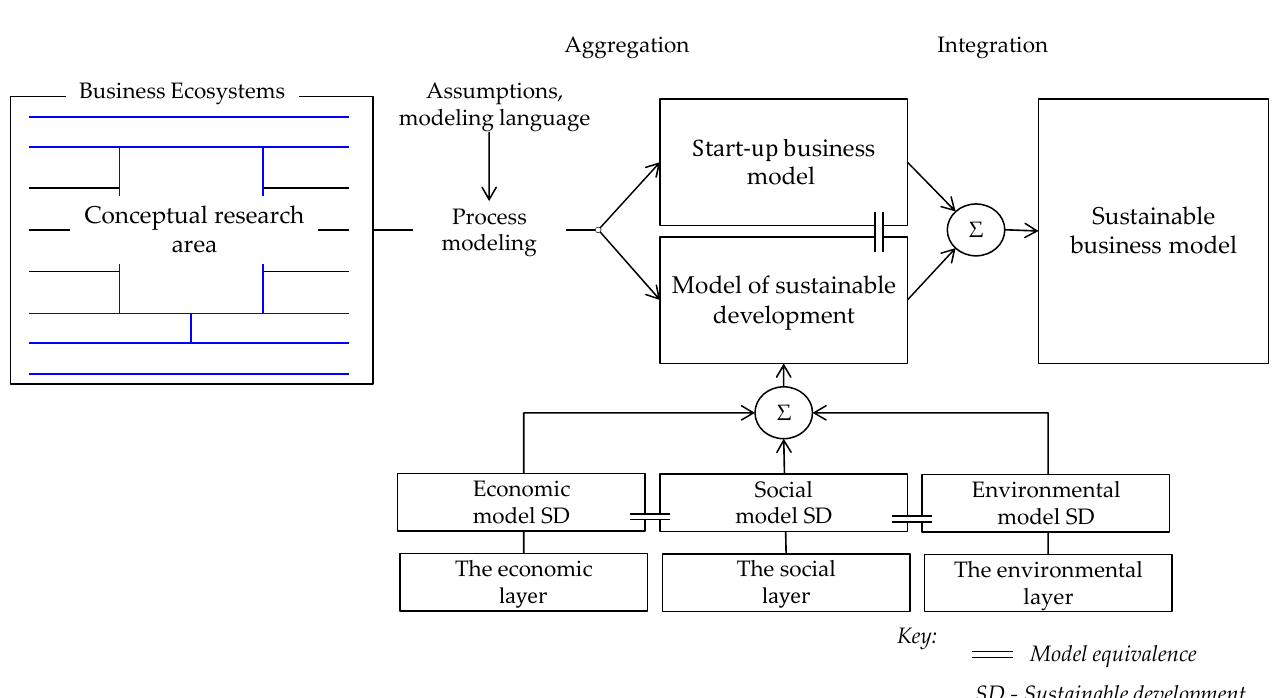
Figure 5. A methodical approach to developing a reference model of sustainable business. Source: author’s own develop- ment.